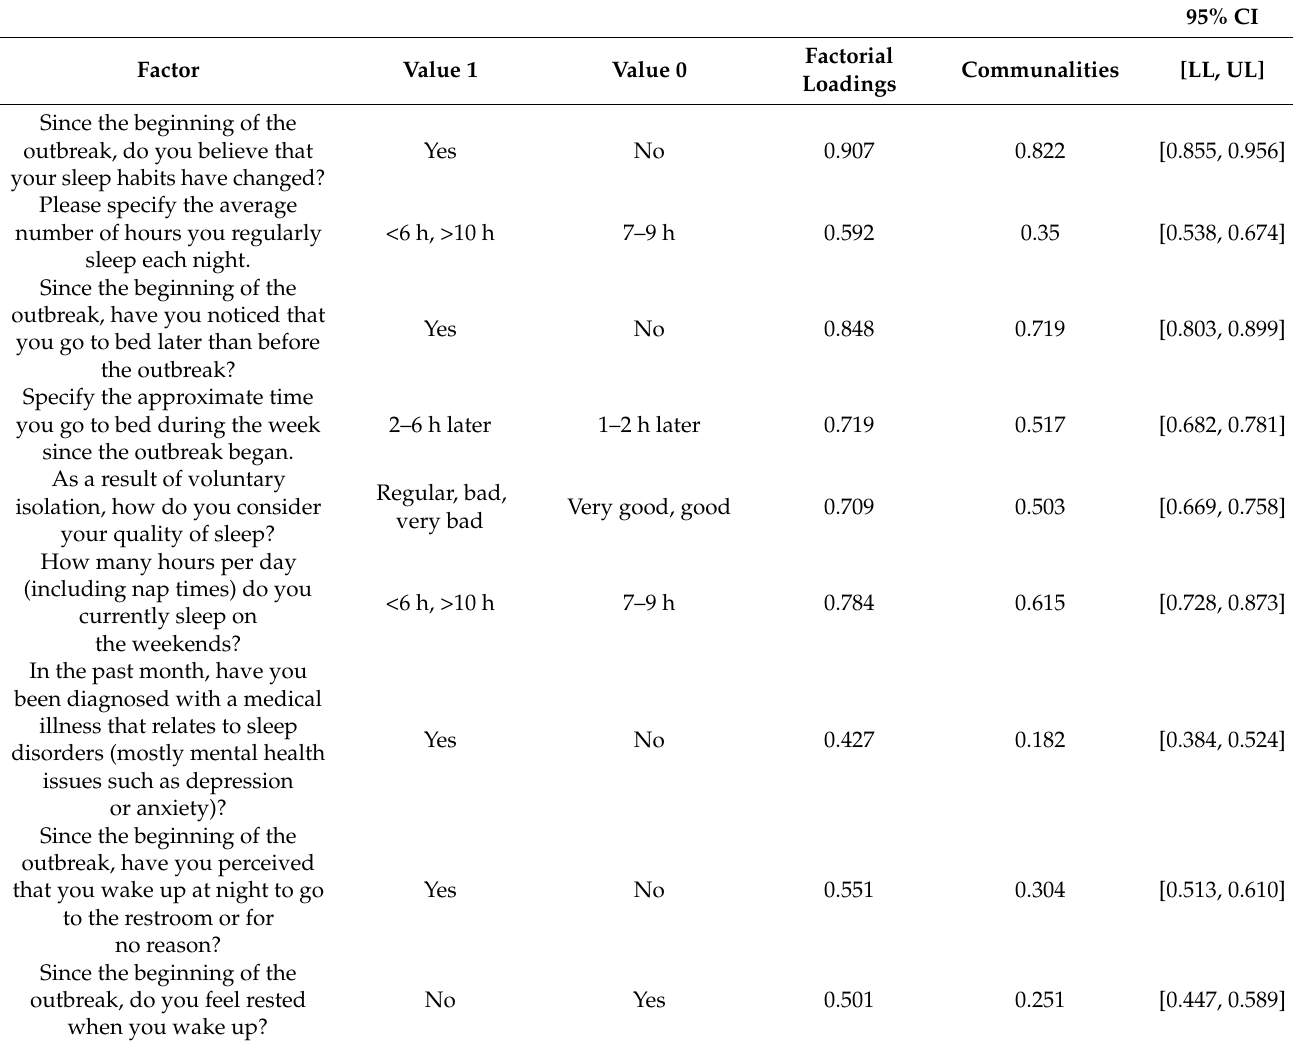
Table 2. Factorial loadings, communalities, and confidence intervals from the tetrachoric matrix for sleep quality measures.